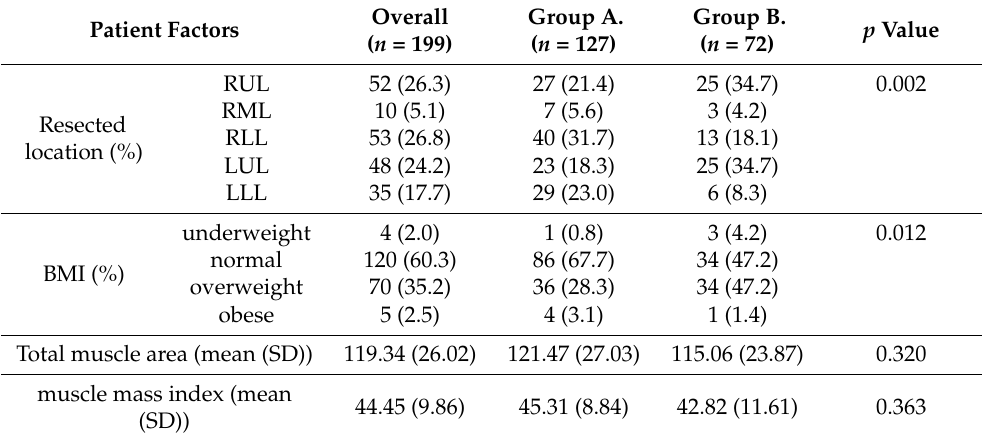
Table 2. Perioperative factors with statistical significance between Group A and Group B.